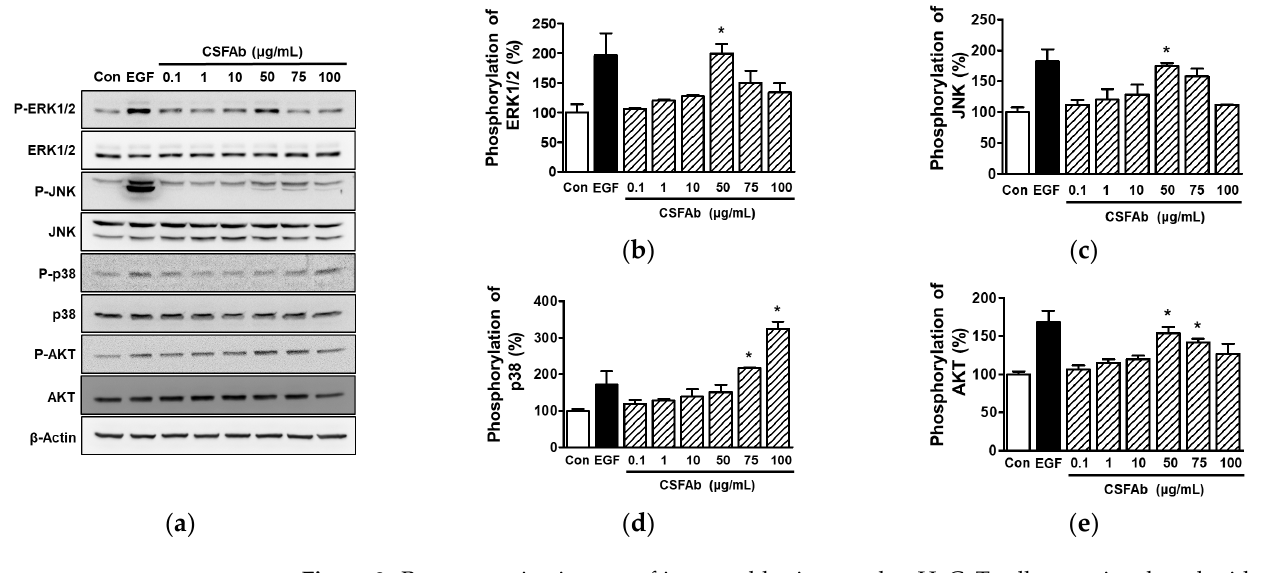
Figure 3. Representative images of immunoblotting results. HaCaT cells were incubated with or without Caragana sinica flower absolute (CSFAb; 0.1–100 μg/mL) for 10 min, and cell lysates were immunoblotted with the indicated antibodies. ( b – e ) Statistical graphs of phosphorylated ERK1/2 (( b ) P-ERK 1/2), JNK (( c ) P-JNK), p38 MAPK (( d ) P-p38), and AKT expression levels (( e ) P-AKT) obtained from panel ( a ). Phosphorylation levels are percentages vs. untreated controls (Con). Recombinant human epidermal growth factor (EGF: 5 ng/mL): positive control. Data are expressed as means ± SEMs ( n = 3/protein). * p < 0.05 vs. untreated controls.